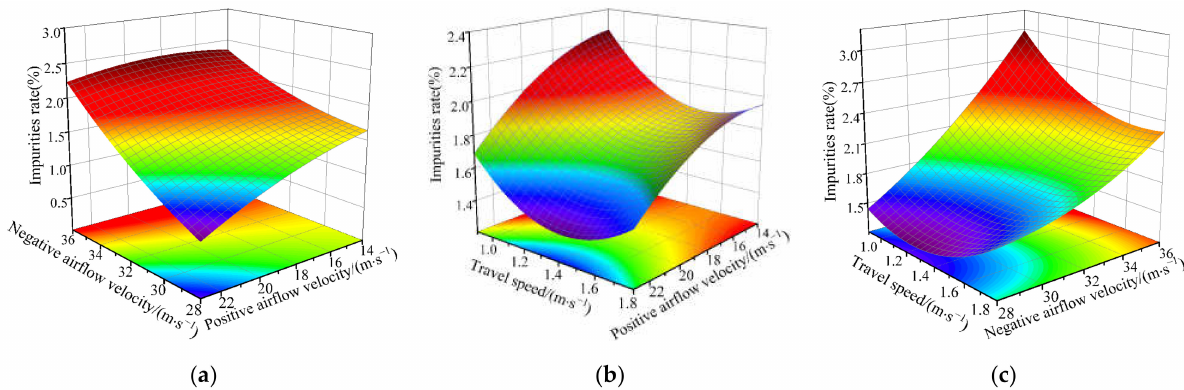
Figure 4. Response surfaces graph of the interaction factors for the impurities rate: ( a ) influ- ence of interaction factors between the positive airflow velocity and the negative airflow velocity, ( b ) influence of interaction factors between the positive airflow velocity and the travel speed, and ( c ) influence of interaction factors between the negative airflow velocity and the travel speed.